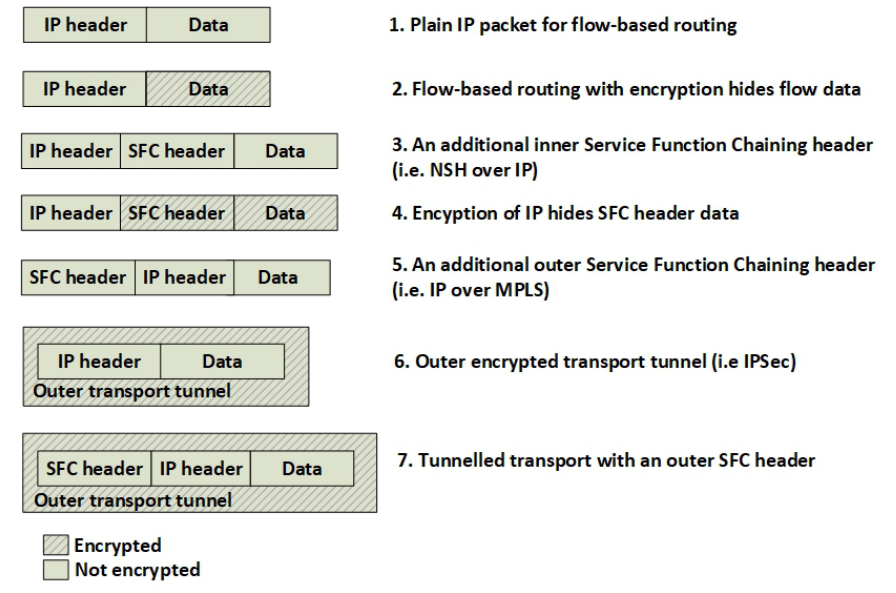
Figure 3. Encryption possibilities.